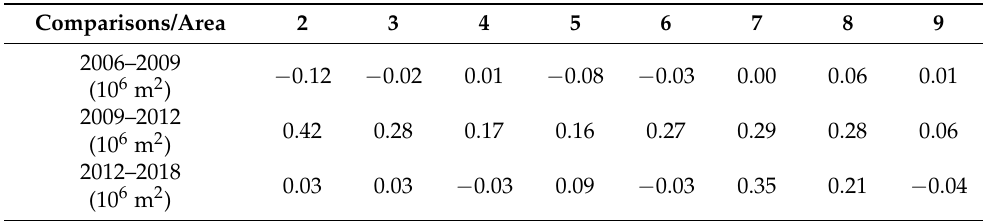
Table 6. Comparison between the emerged surfaces for the eight sub-areas of the PRD computed using the 0 m contour lines level, extracted from LiDAR data, and corrected on the basis of the simultaneous ortho-images (final coastlines) together with the common boundaries between the different surveys.